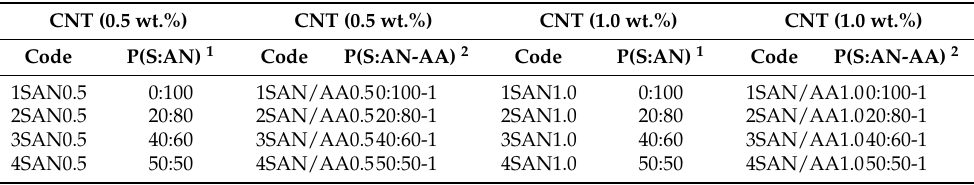
Table 1. Composition of composite polymers and code names.